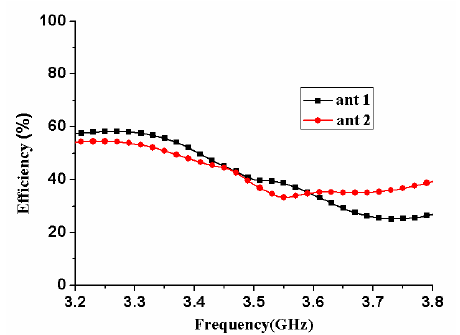
Figure 14. The radiation efficiency of the proposed MIMO antenna array.